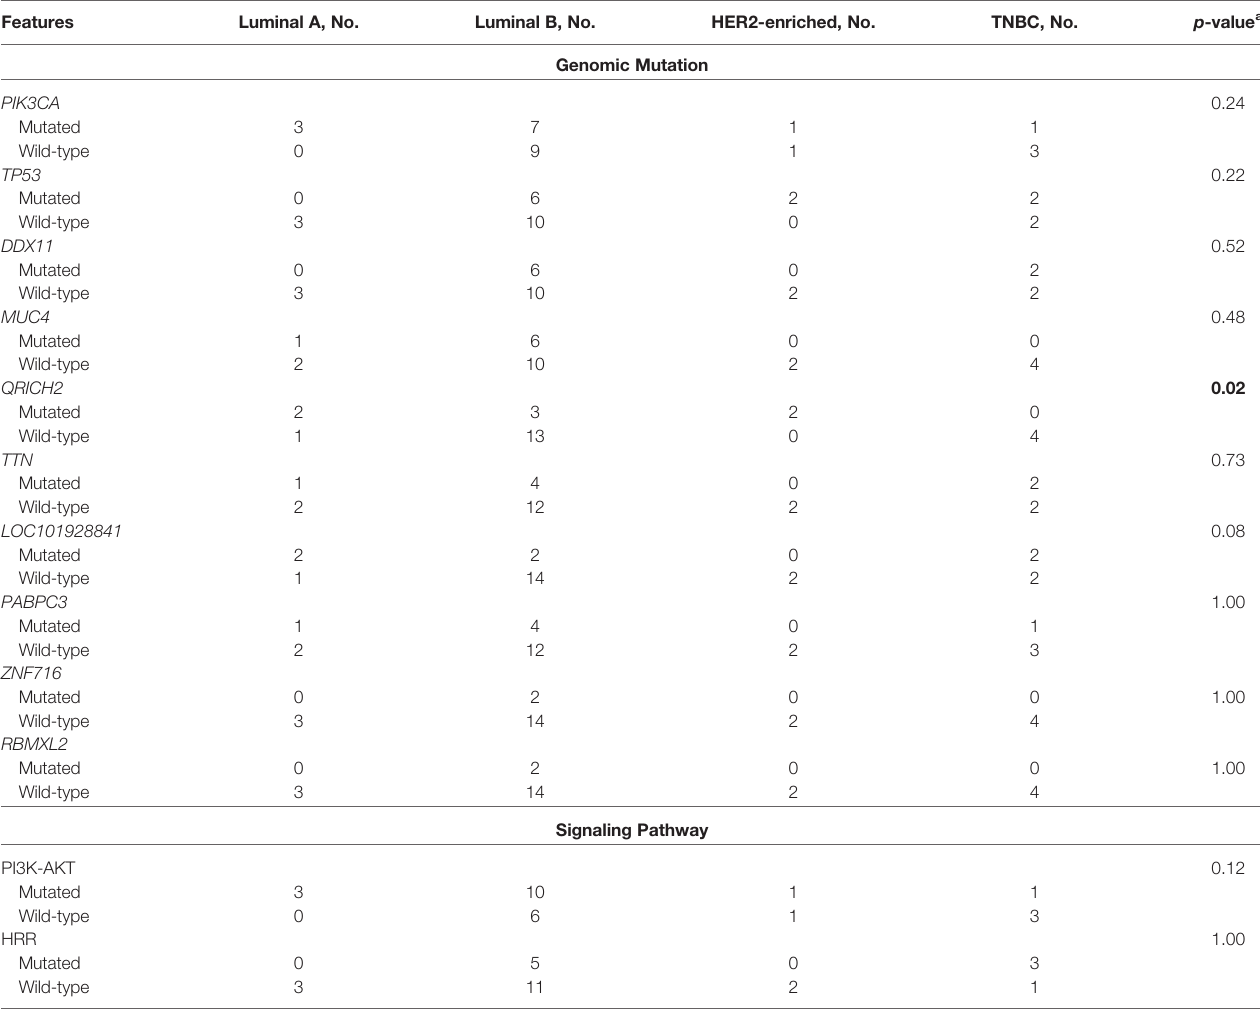
TABLE 4 | Genomic Features in Relation to Breast Cancer Subtypes.